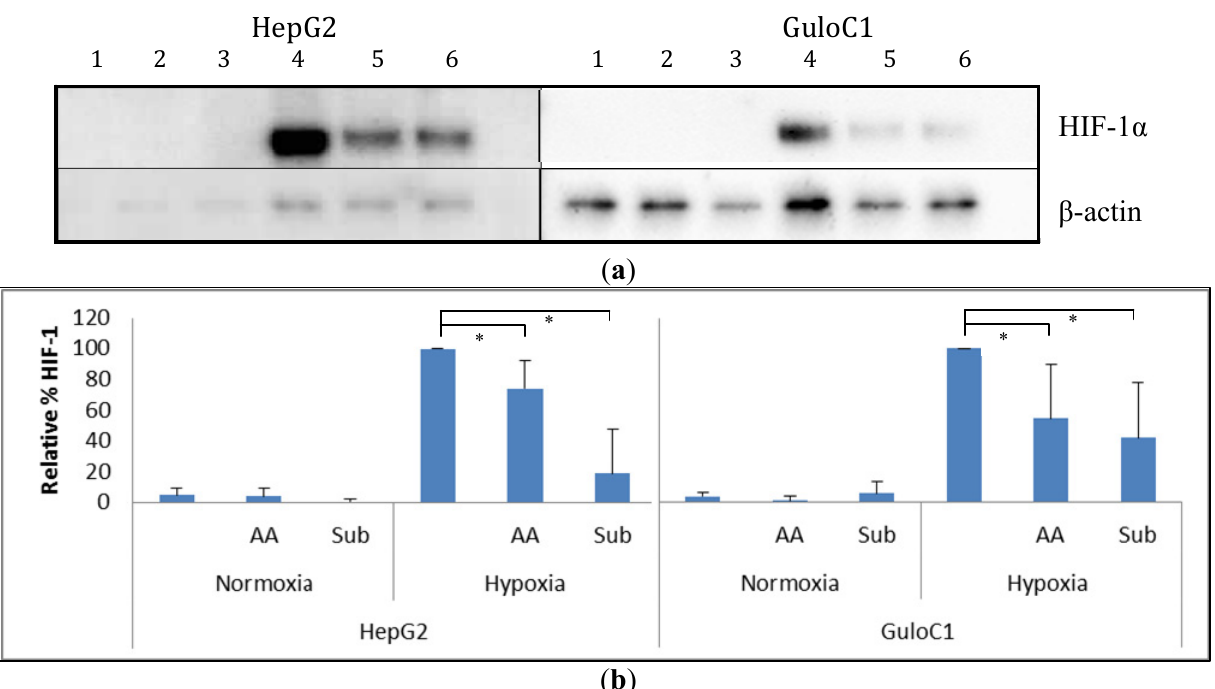
Figure 5. Western blot analysis of HIF-1 α protein in HepG2 parental and HepG2